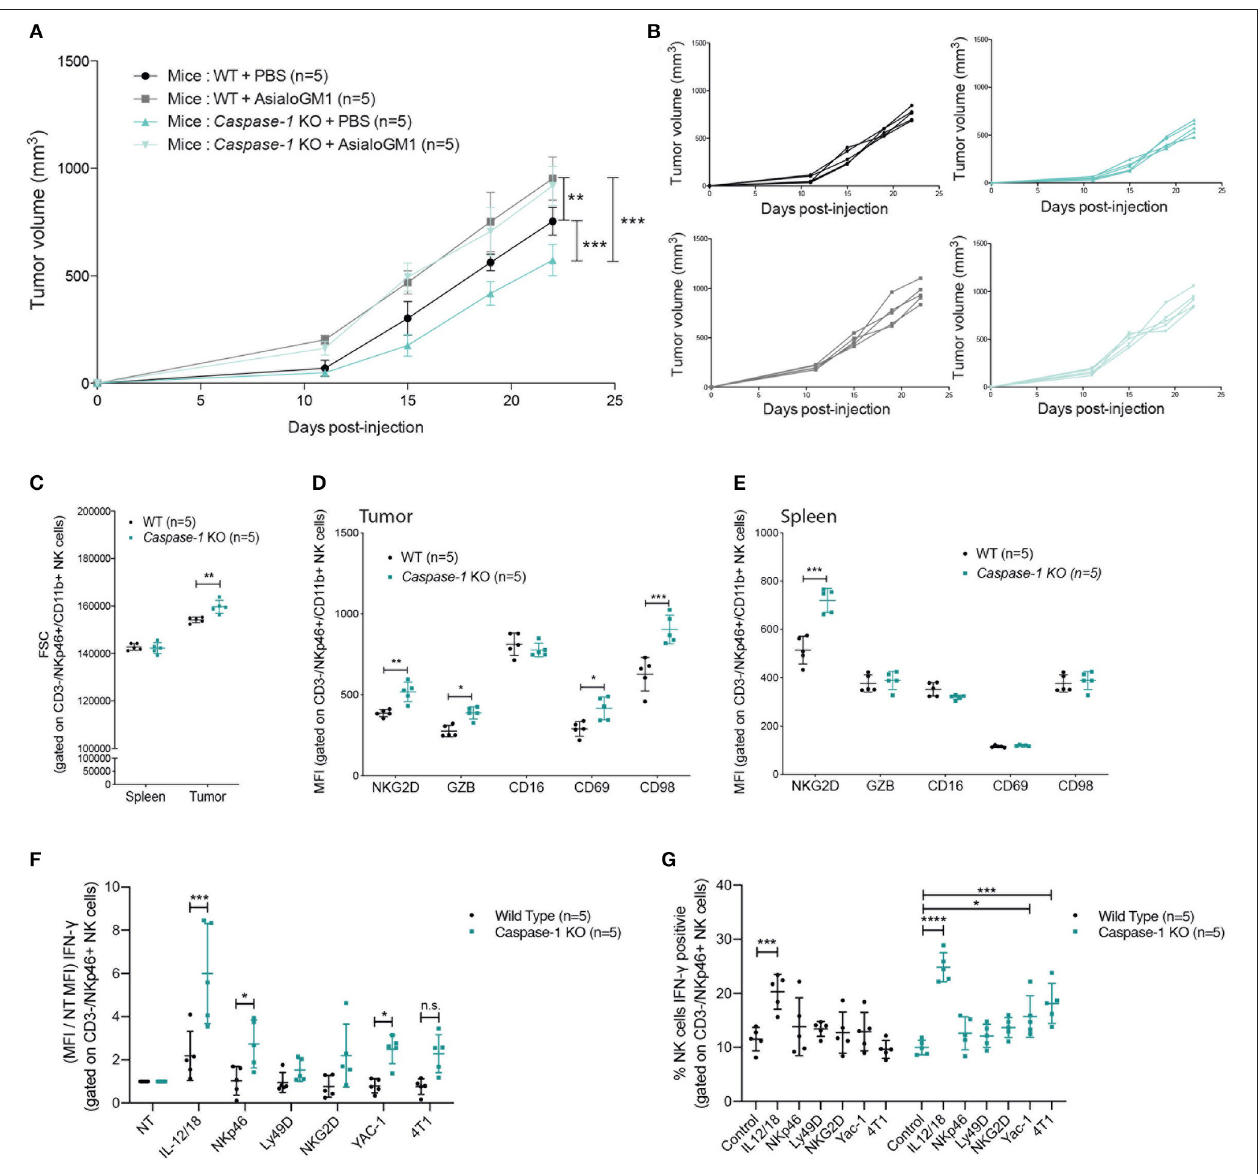
FIGURE 6 | NK cells control tumor growth and are more active in caspase-1 KO mice. (A) Tumor growth of 4T1 cells was measured in NK-depleted (anti-asialo GM1) or PBS-treated WT and caspase-1 KO mice ( n = 5). Each value represents mean ± SD ** P < 0.01; *** P < 0.001 (Two-way ANOVA analysis). (B) Individual growth curves depicted in (A) . (C–E) Flow cytometry analysis of NK cell size in tumors and spleens (C) and activation markers in 4T1 tumors (D) and in spleen (E) from WT ( n = 5) and Caspase-1 KO ( n = 5) mice at day 7 post-injection. (F) Cell suspensions from digested tumors of the indicated mouse genotype were cultured in the presence of cytokines (IL-12/IL-18), antibodies (NKp46, Ly49D, NKG2D) or tumor cells (YAC-1, 4T1) and NK cell IFN- γ production (F) or IFN- γ positive cells (G) were measured by flow cytometry. Data from (C–G) represent mean ± SD * P < 0.05; ** P < 0.01; *** P < 0.001; **** P < 0.0001 (Two-way ANOVA test followed by Bonferroni’s Post-test; ns,